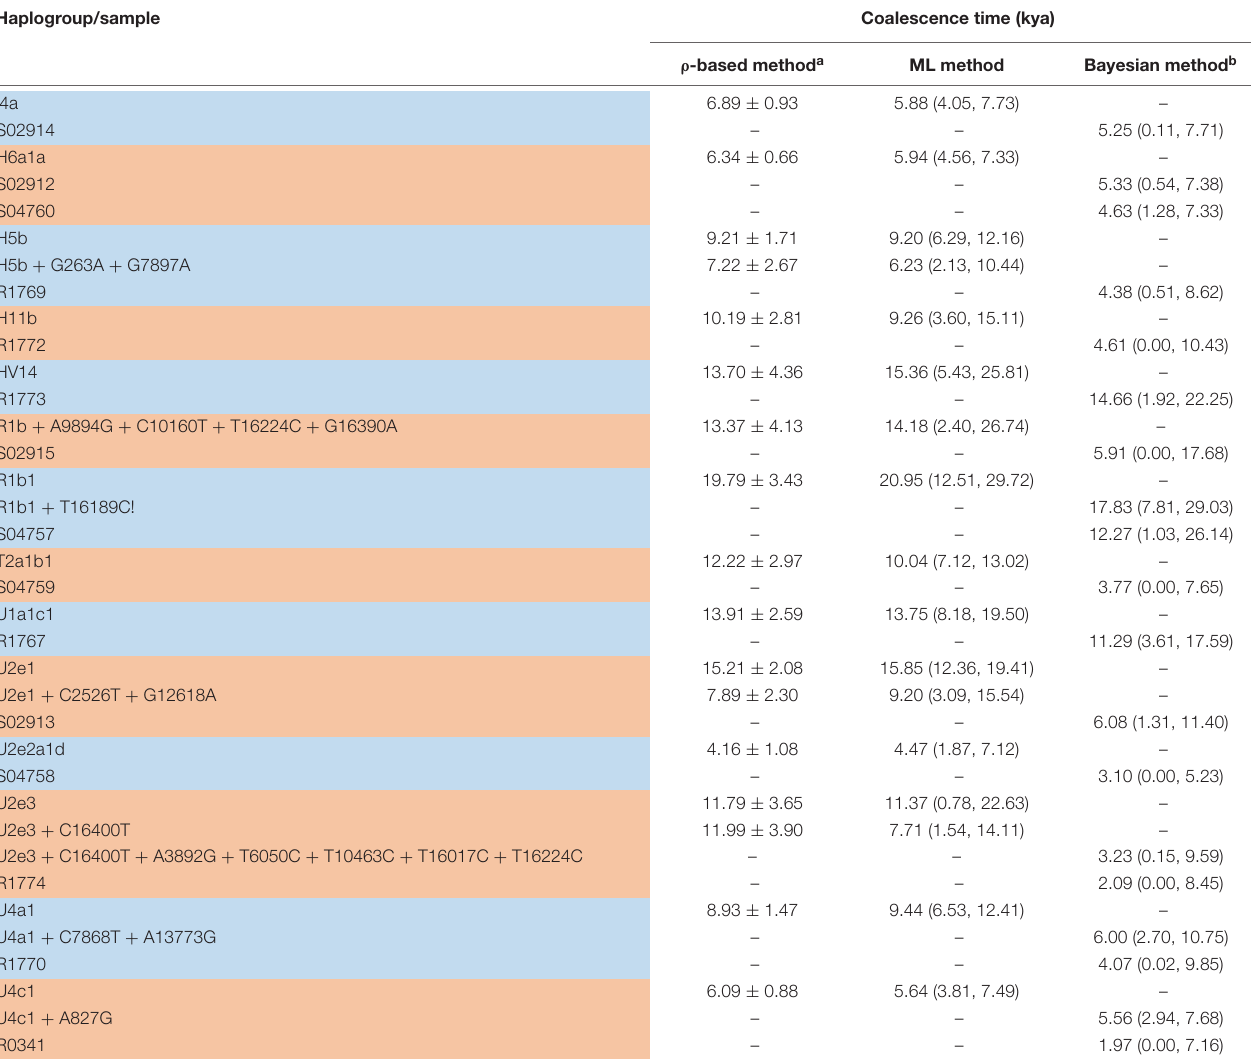
TABLE 2 | TMRCA of XBD mtDNA haplogroups estimated from modern mtDNA genomes.